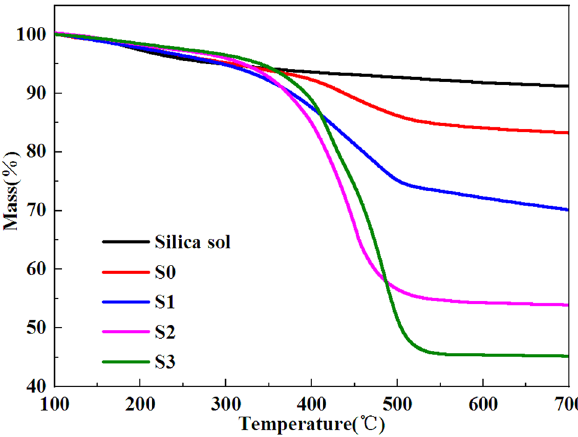
Figure 2: TG curves of di ff erent